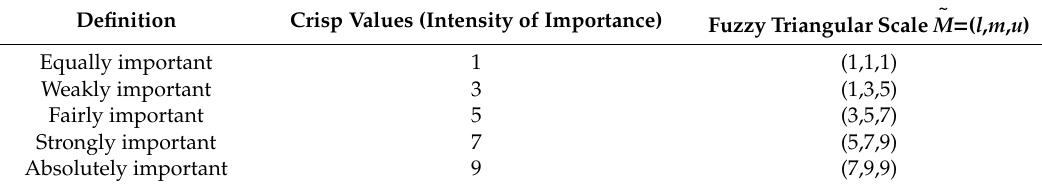
Table 1. Equivalence between linguistic values and triangular fuzzy numbers.